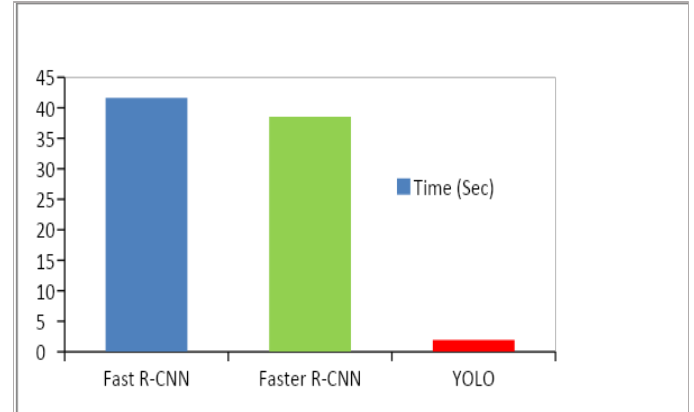
Figure 10. Time is taken to detect.